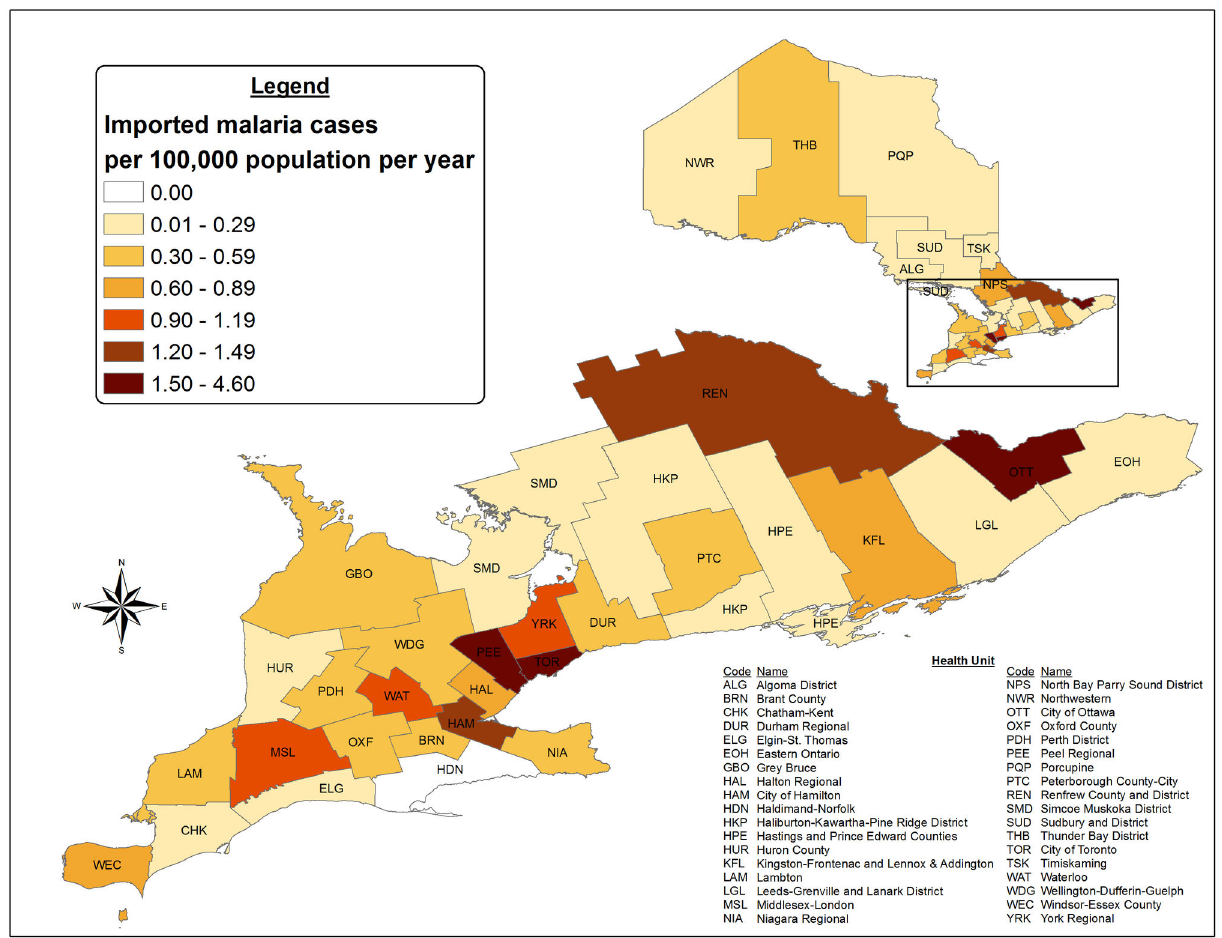
Figure 8. Imported malaria distribution and case rate in Ontario’s health units (1990–2009).